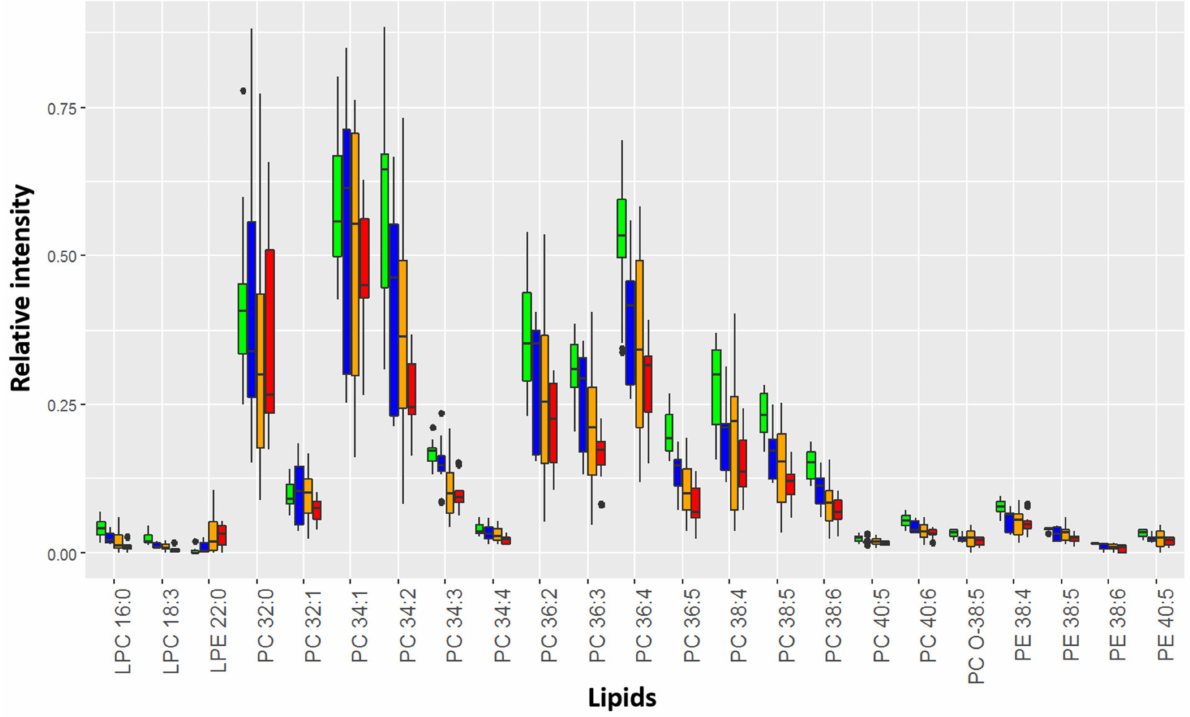
Figure 3. Relative intensity of marker lipids in the mass spectrum of affected tissues. Green cor- responds to chronic cervicitis, blue to LSIL, yellow to HSIL, and red to SCC. The diagram shows Q1–1.5*IQR, Q1, Me, Q3, and Q3 + 1.5*IQR. Black dots correspond to